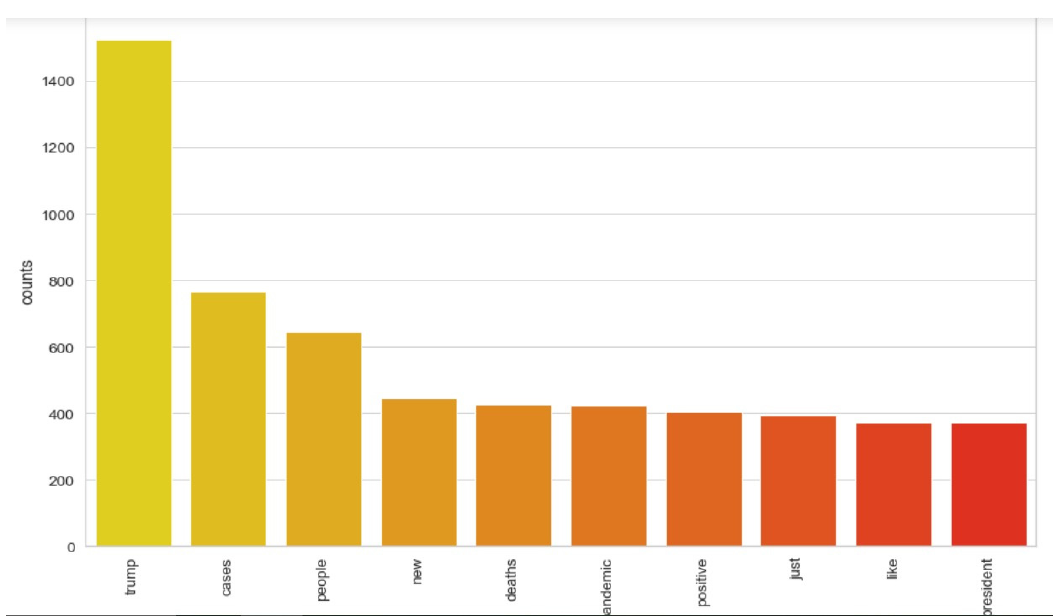
Figure 7. Top 10 most frequent words for the mined dataset.